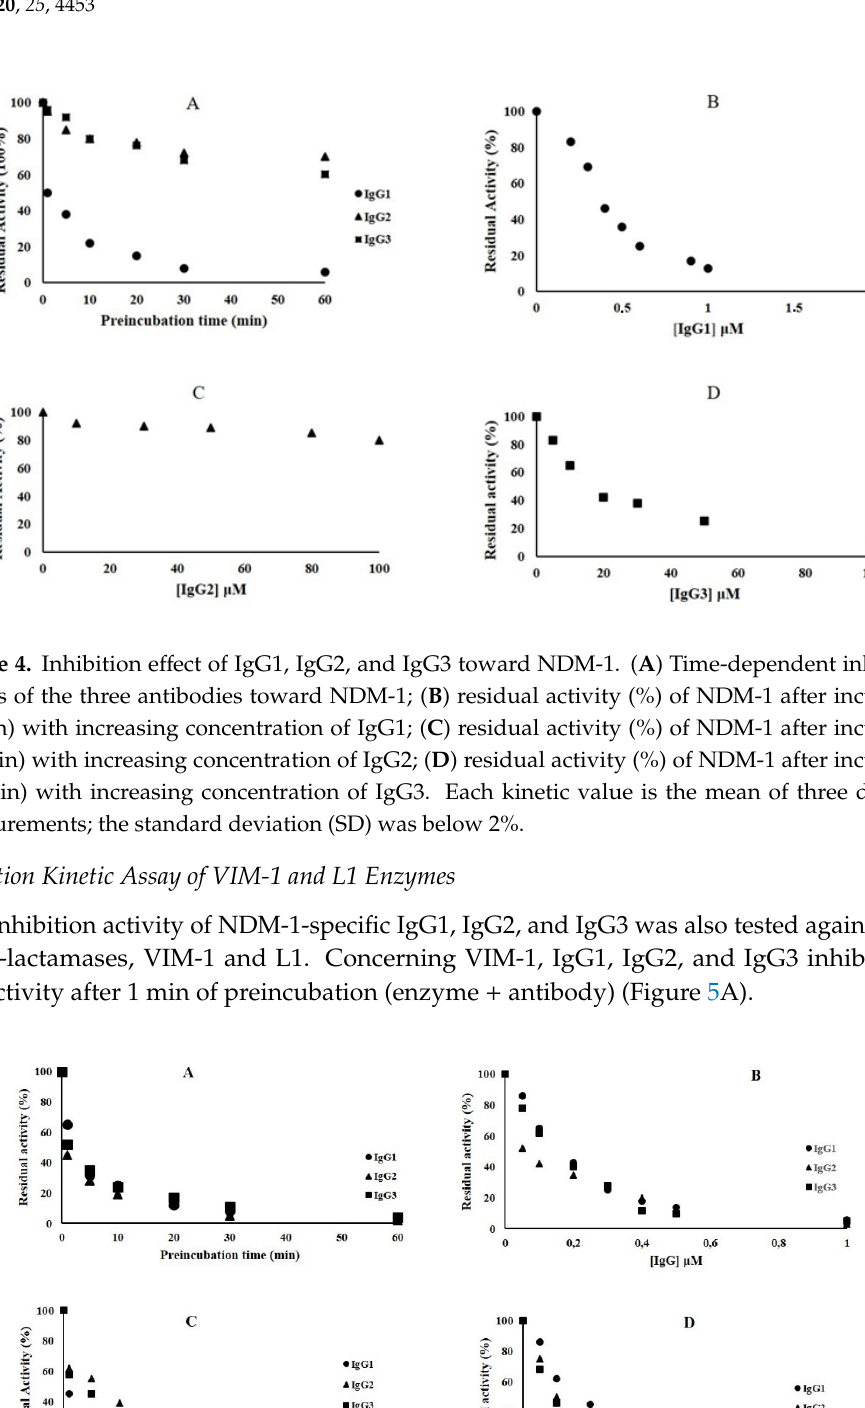
Figure 4. Inhibition effect of IgG1, IgG2, and IgG3 toward NDM ‐ 1. ( A ) Time ‐ dependent inhibition assays of the three antibodies toward NDM ‐ 1; ( B ) residual activity (%) of NDM ‐ 1 after incubation (1 min) with increasing concentration of IgG1; ( C ) residual activity (%) of NDM ‐ 1 after incubation (60 min) with increasing concentration of IgG2; ( D ) residual activity (%) of NDM ‐ 1 after incubation (60 min) with increasing concentration of IgG3. Each kinetic value is the mean of three different measurements; the standard deviation (SD) was below 2%. Table 2. Half maximal inhibitory concentration (IC 50 ) calculated for IgG1, IgG2, and IgG3 versus